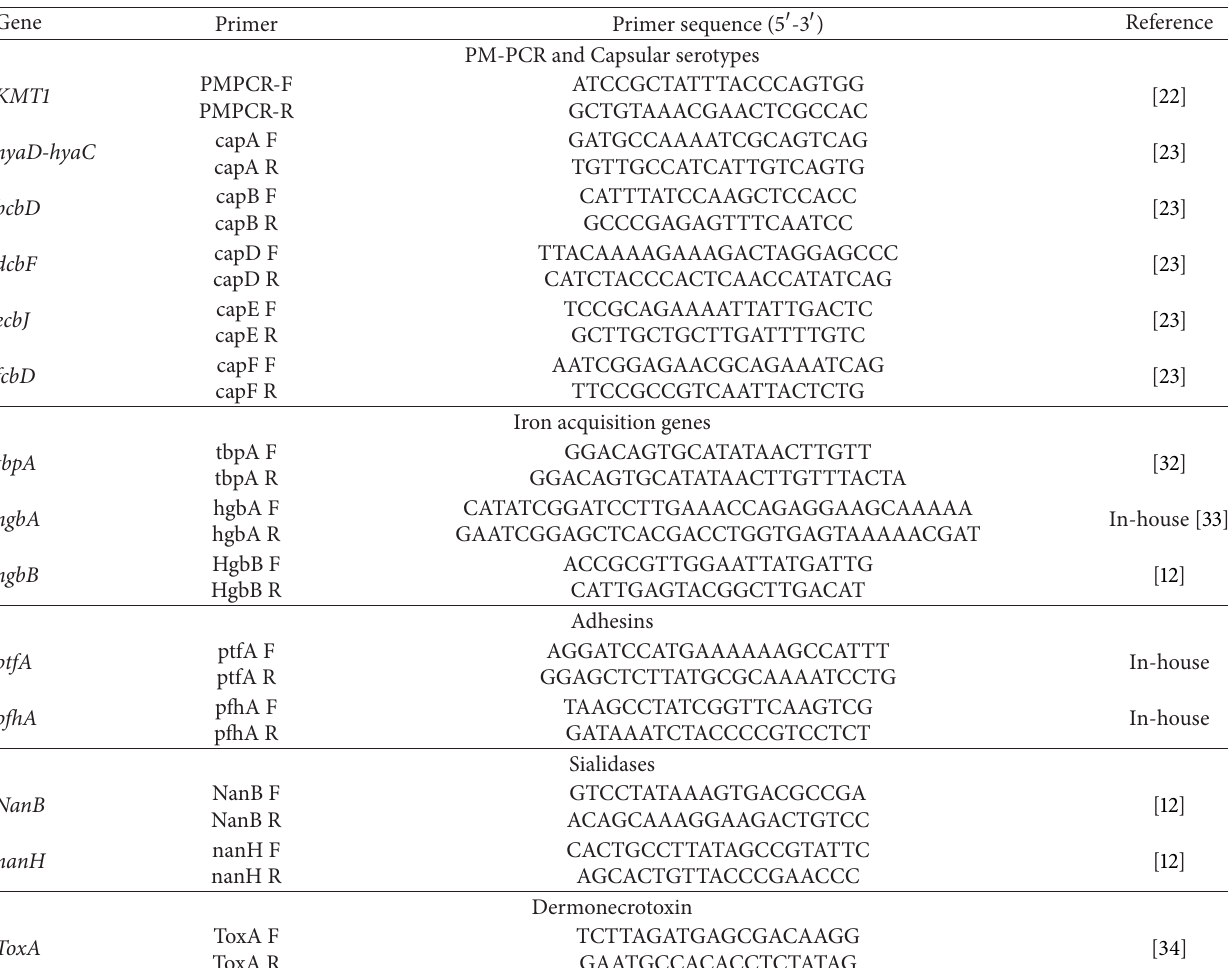
Table 2: Details of primers and citations used for the detection of capsular type and virulence associated genes in strains of Pasteurella multocida